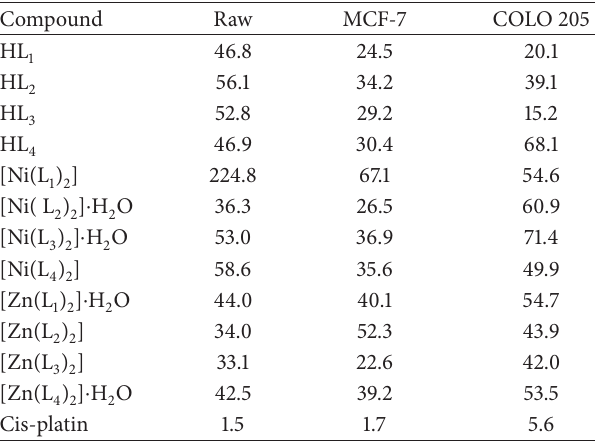
Table 8: IC values ( 𝜇 g/mL) of cytotoxic activity of ligands and 50 their metal